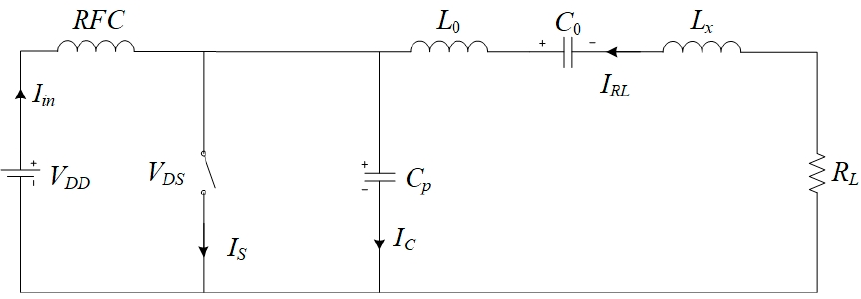
Figure 1. Class-E model under ideal condition.